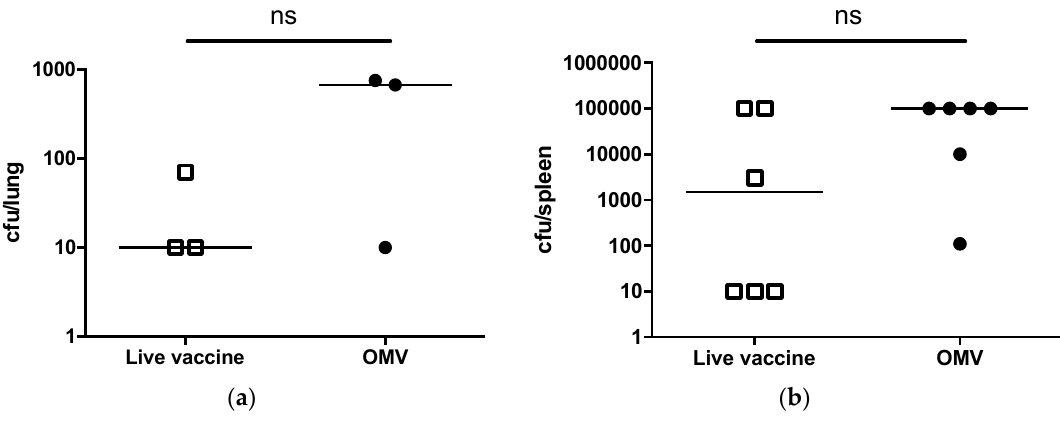
Figure 2. Immunized C57Bl/6 mice are persistently colonized with B. mallei . B. mallei bacterial burdens in the ( a ) lungs ( n = 3 per group) or ( b ) spleen ( n = 6 per group) of surviving mice immunized with OMV or live vaccine (ns = not significant; lungs, p = 0.13 and spleens, p = 0.09 by t -test).